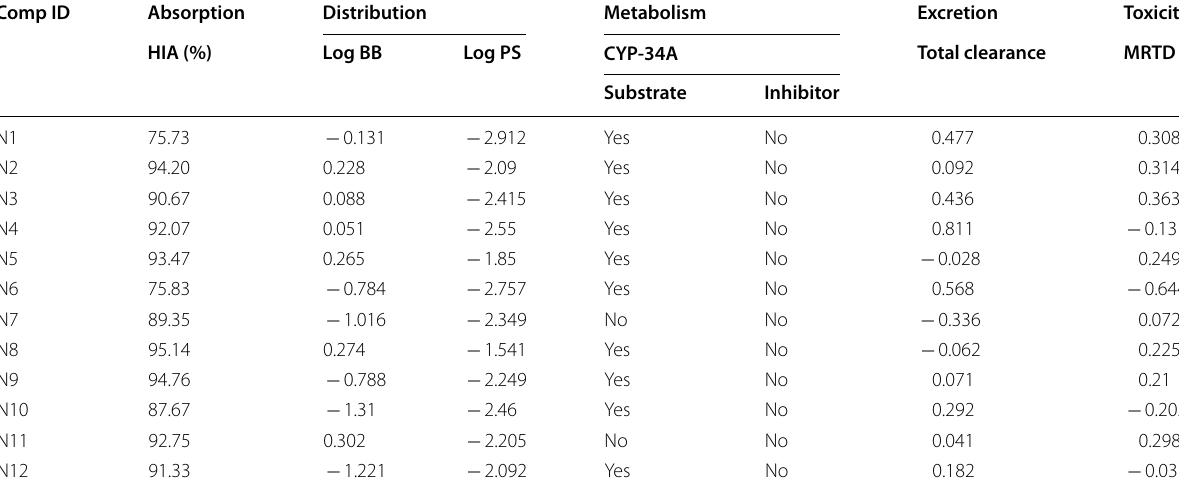
Table 14 Predicted ADMET properties of the newly designed compounds